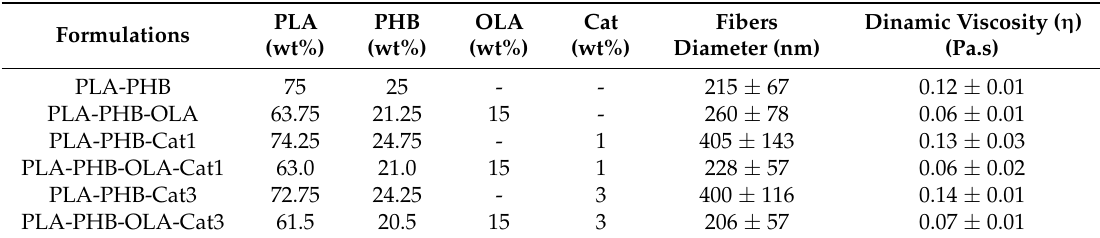
Table 1. Electrospun PLA-PHB fibers and their